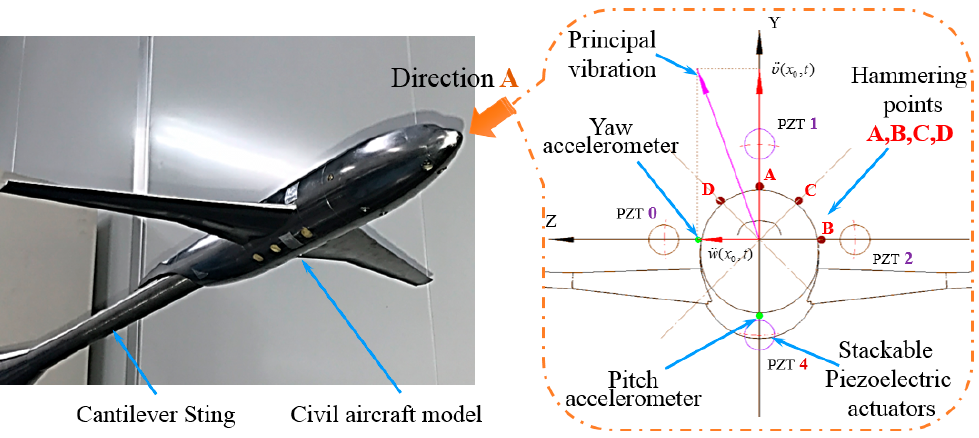
Figure 5. Distribution diagram of the hammering points (Direction A).